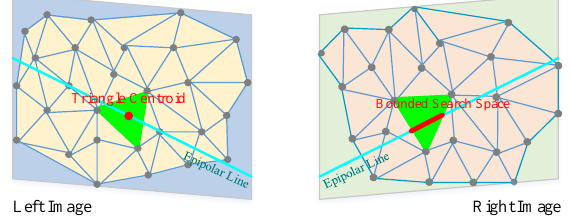
Figure 4. The bounded search space for conjugate feature